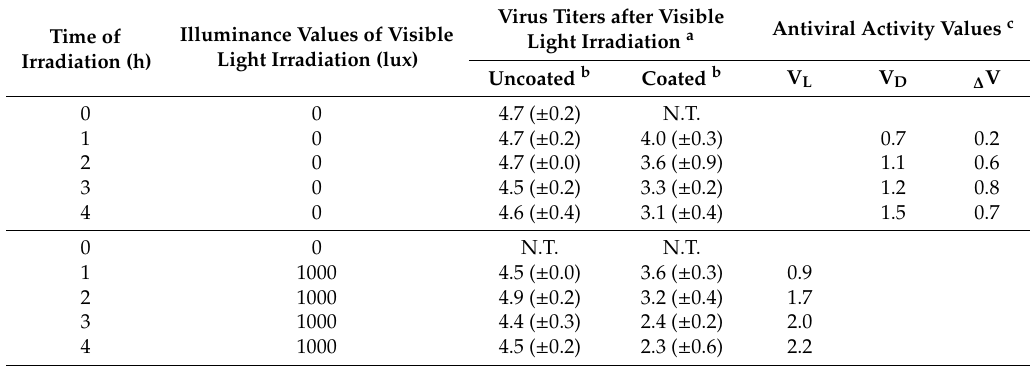
Table 2. Inactivation of bovine coronavirus on photocatalytic uncoated and coated films harvested every 1 h with or without 1000 lux light irradiation for 4 h. Time of Irradiation